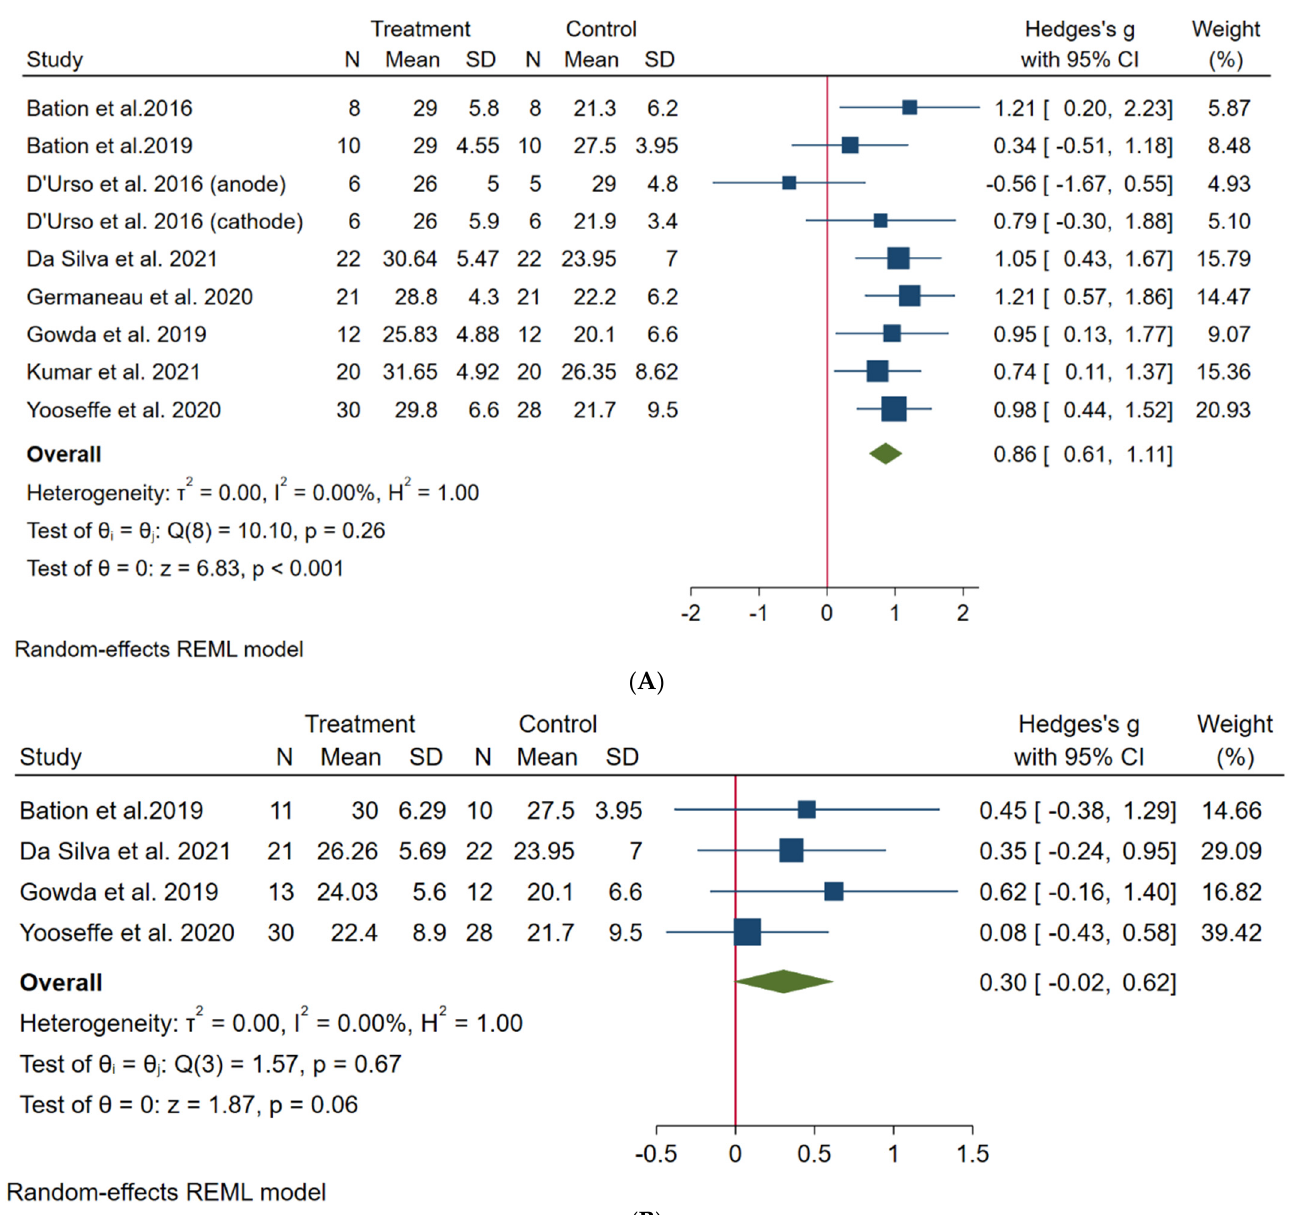
Figure 2. Forest plots. ( A ) Primary outcome: comparison between baseline and endpoint of active groups [19–26]. ( B ) Secondary outcome: comparison between endpoints of both active and placebo groups [20,22,24,25].